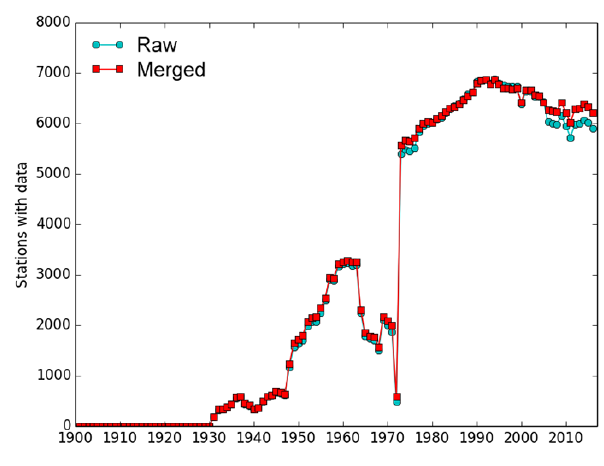
Figure 2. Time sequence of the number of stations before (cyan circles) and after (red squares)